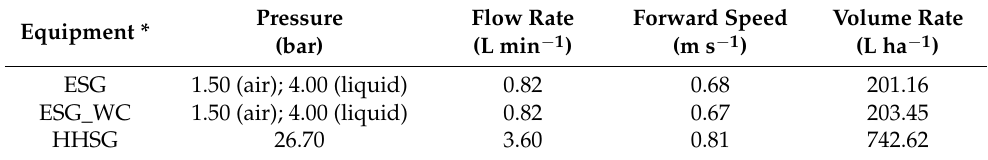
Table 1. Pressure, flow rate, forward speed, and volume rate in each of the tests carried out. Equipment